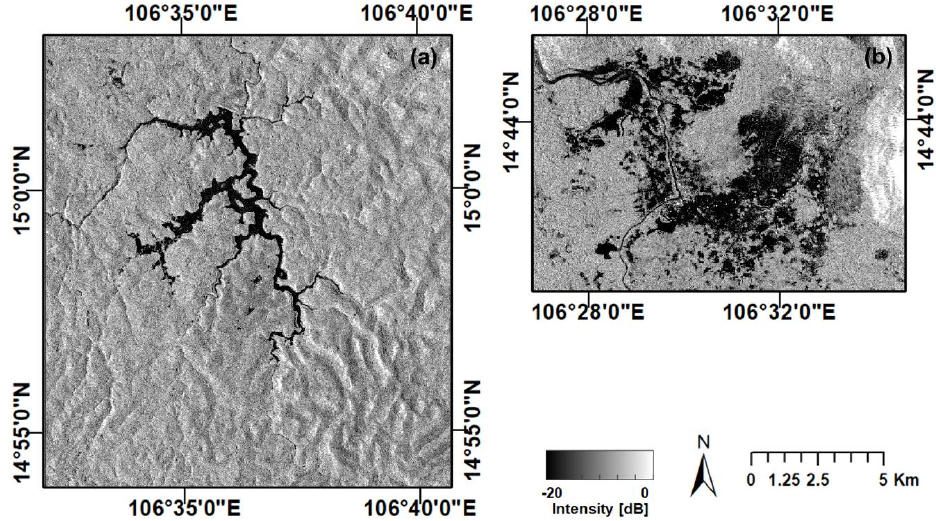
Figure 6. Intensity image acquired on 25 July 2018, after the dam collapse at ( a ) Xe-Namnoy reservoir, and ( b ) Hinlat area.